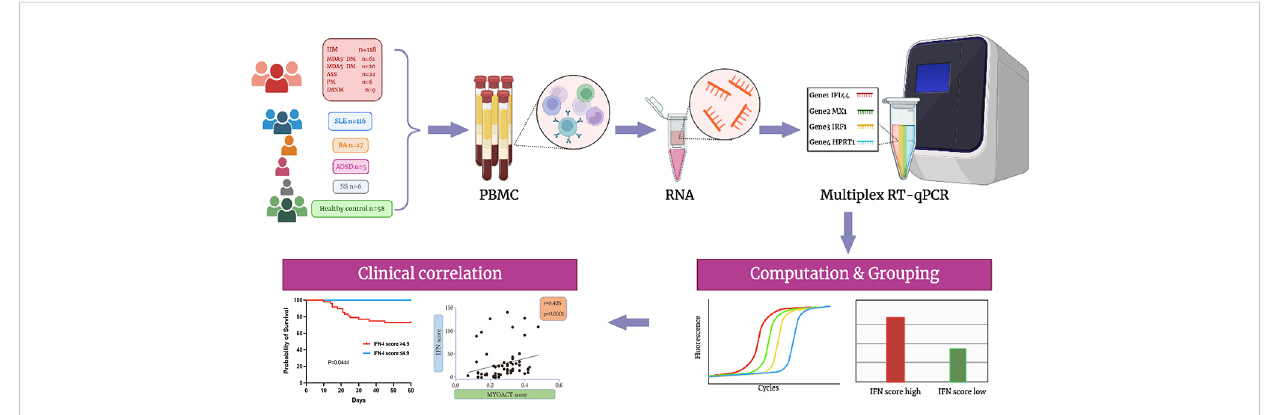
FIGURE 1 Flowchart illustrating the overall experimental design of the study. Biorender and Adobe Illustrator were used to create the